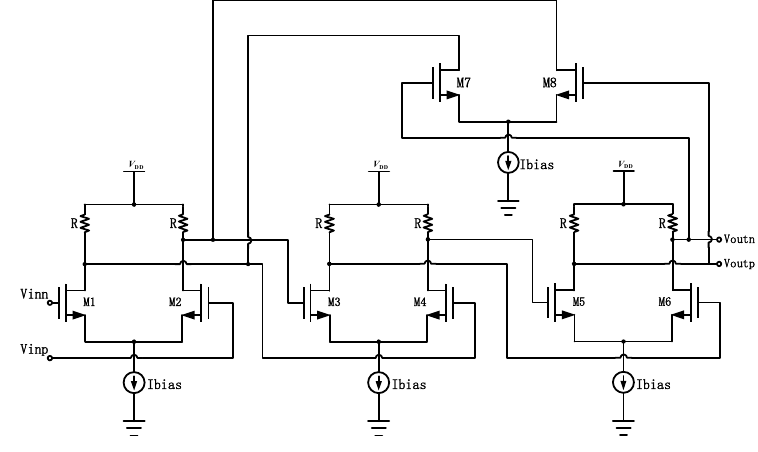
Figure 11. Fixed gain amplifier (FGA) schematic. Table 8. Component sizes and simulated performance specifications.